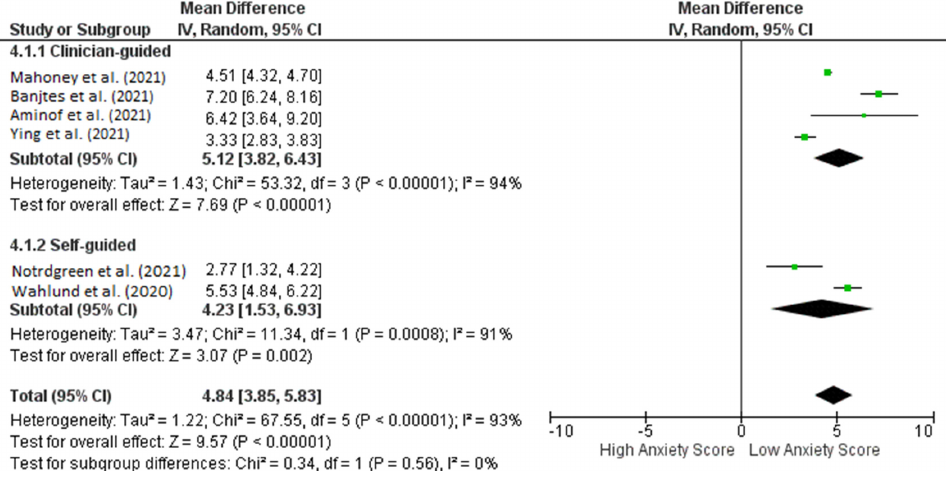
Figure 5. Subgroup analysis for studies analyzing pre- and post-ICBT intervention in anxiety based on methods of intervention (clinician-guided vs. self-guided).